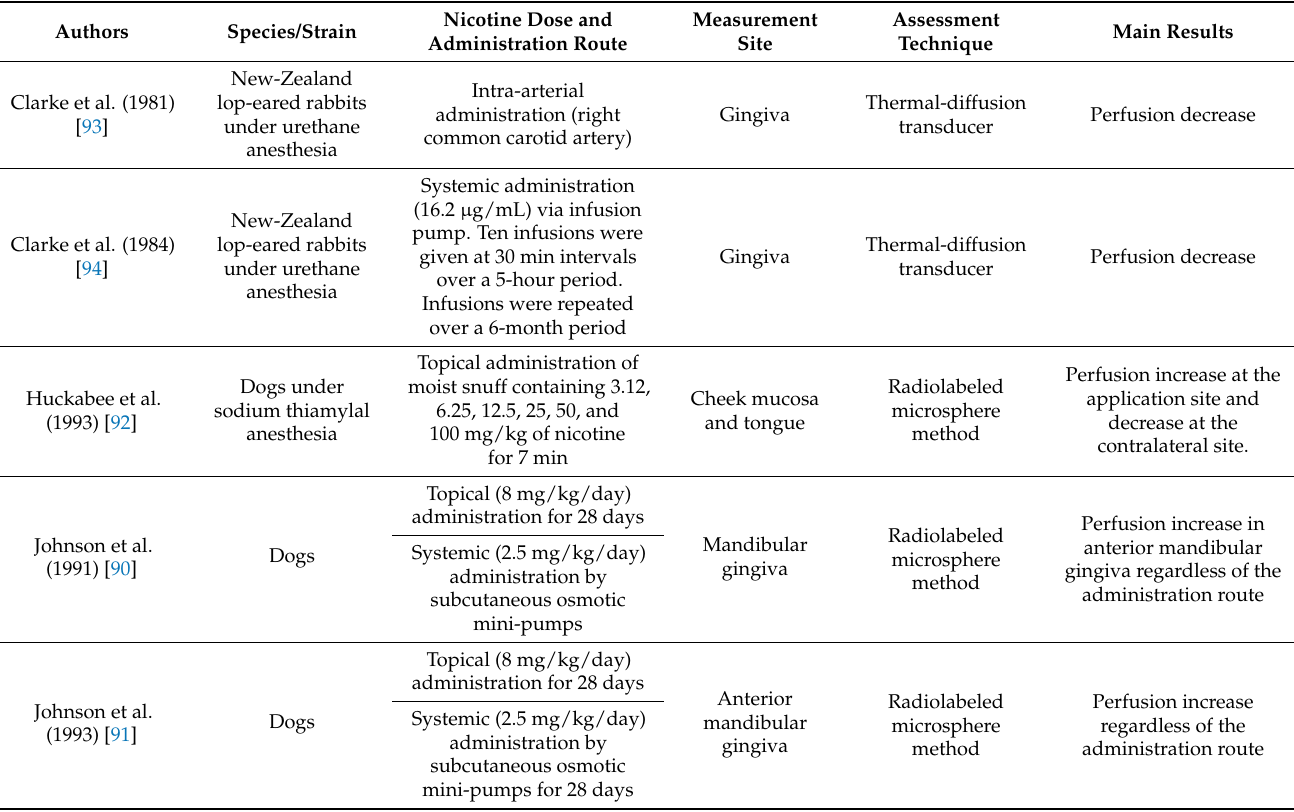
Table 1. Description of the main results of the most relevant studies into the effect of nicotine on oral microcirculatory perfusion in